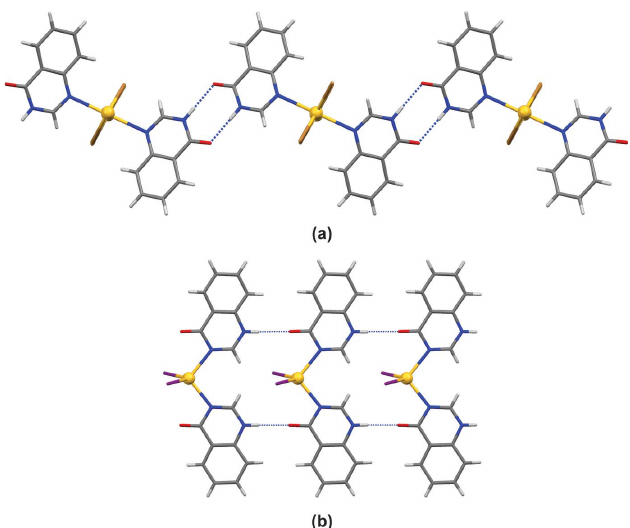
Figure 10 ( a ) Adjacent metal-containing building units ( Mercury 3.3 , capped sticks) in the crystal structure of [CdBr 2 (4-quz) 2 ] n ( 8 ) linked by two N—H (cid:2)(cid:2)(cid:2) O ð 8 Þ motifs. ( b ) Neighbouring metal-containing hydrogen bonds forming R 2 2 building units in the crystal structure of [Cd 2 I 2 (4-quz) 2 ] ( 9 ) linked by two ð 16 Þ catemeric single-point N—H (cid:2)(cid:2)(cid:2) O hydrogen bonds forming C ð 6 Þ R 2 2